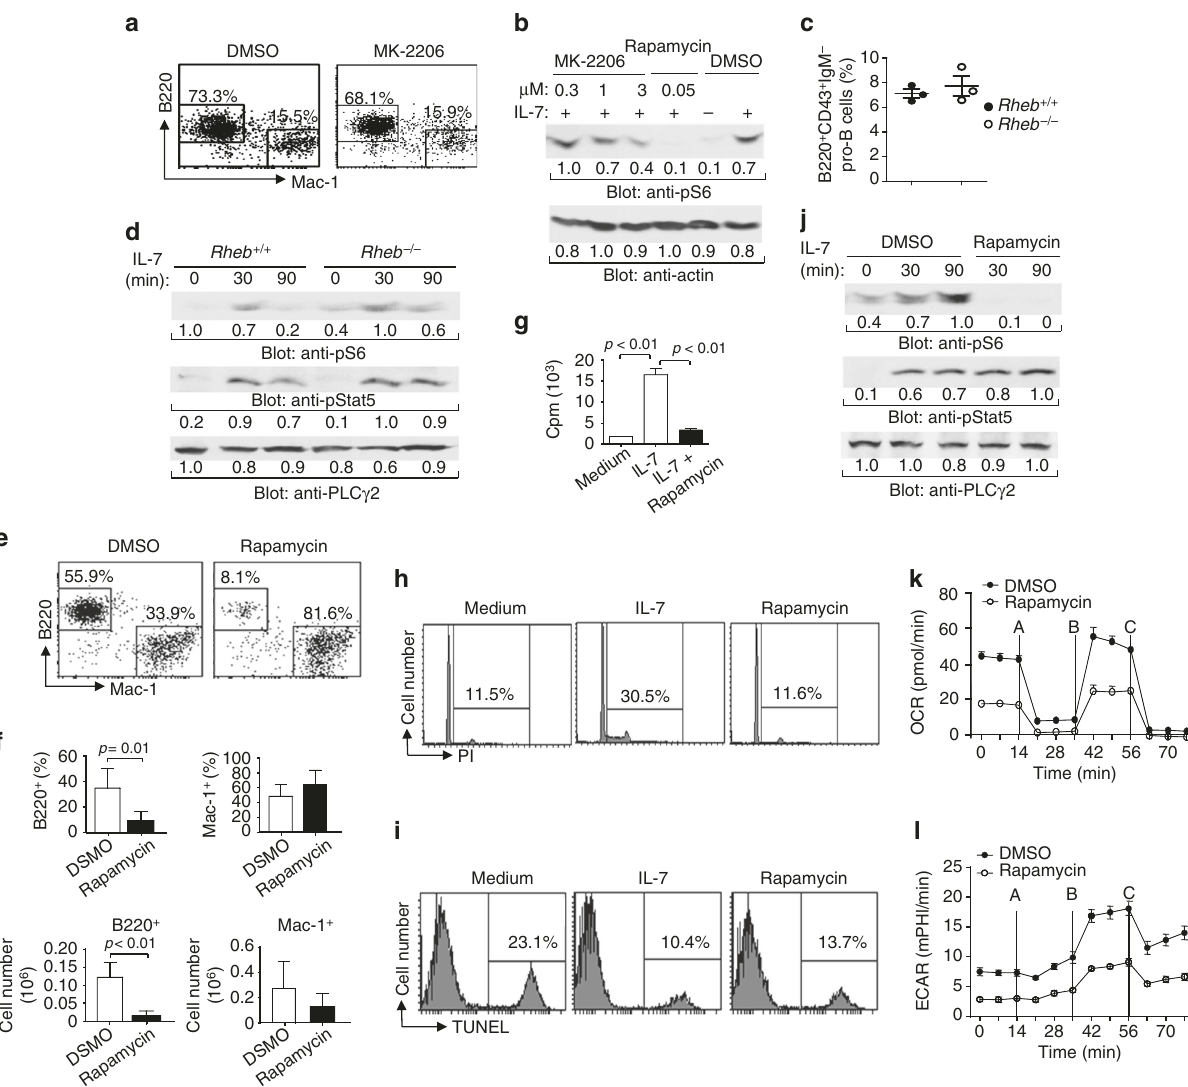
Fig. 8 IL-7-mediated mTOR activation is Akt/Tsc/Rheb pathway-independent. a AKT inhibition does not affect IL-7-dependent B cell production. Wild-type Lin − BM cells were cultured on OP9 cells plus IL-7 for 1 day and then treated with DMSO or MK-2206. Numbers indicate percentages of B220 + and Mac-1 + cells in the gated live cells. b AKT inhibition does not block S6 phosphorylation. Pro-B cells derived from Rag1 -de fi cient BM were pre-treated with DMSO, MK-2206 or rapamycin for 10 min and then stimulated with IL-7 for 90 min. Cell lysates were subjected to Western analysis. c Rheb de fi ciency does not affect early B cell development. The percentages of pro-B cells in the gated BM B220 + cells of Rheb +/+ and Rheb − / − mice. d IL-7-induced mTOR activation is Rheb-independent. Pro-B cells derived from Rheb +/+ and Rheb − / − BM were stimulated with IL-7. Cell lysates were subjected to western analysis. e , f mTOR pathway inhibition impairs IL-7-dependent B cell production. Wild-type Lin − BM cells were cultured on OP9 cells plus IL-7 for 1 day and then treated with DMSO or rapamycin. Numbers indicate percentages of B220 + and Mac-1 + cells in the gated live cells ( e ). Bar graphs show the percentages and numbers of B220 + and Mac-1 + cells ( f ). g – i mTOR pathway inhibition blocks or partially impairs IL-7-mediated B cell progenitor proliferation or survival, respectively. Pro-B cells derived from Rag1-de fi cient BM were cultured without IL-7 (medium) or with IL-7 plus DMSO or rapamycin. Cell proliferation was determined by [ 3 H] thymidine incorporation ( g ), cell-cycle analysis was performed by PI staining h , and cell survival was measured by TUNEL staining ( i ). j – l mTOR inhibition impairs IL-7-mediated S6 phosphorylation and metabolism in B cell progenitors. Pro-B cells derived from Rag1- de fi cient BM were stimulated with IL-7 plus or minus rapamycin. Cell lysates were subjected to western analysis ( j ). These pro-B cells were cultured with IL-7 plus DMSO or rapamycin. After basal OCR ( k ) and ECAR ( l ) measurement, oligomycin A (A), FCCP (B), and antimycin (C) were sequentially added. Error bars show ± SEM. Data shown are obtained from or representative of 2 ( a , b , d ), 3 ( c ), 5 ( e , f , k , l ), 6 ( g , j ), and 7 ( h , i ) independent